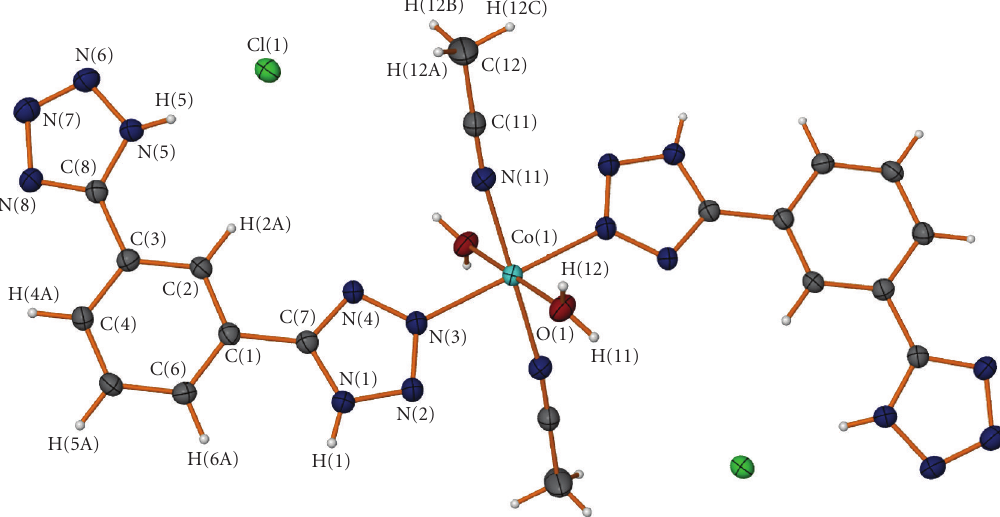
Figure 1: View of the cobalt complex in 1 , shown in approximately the same orientation, with the atom-labelling scheme. Ellipsoids represent displacement parameters at the 40% probability level.